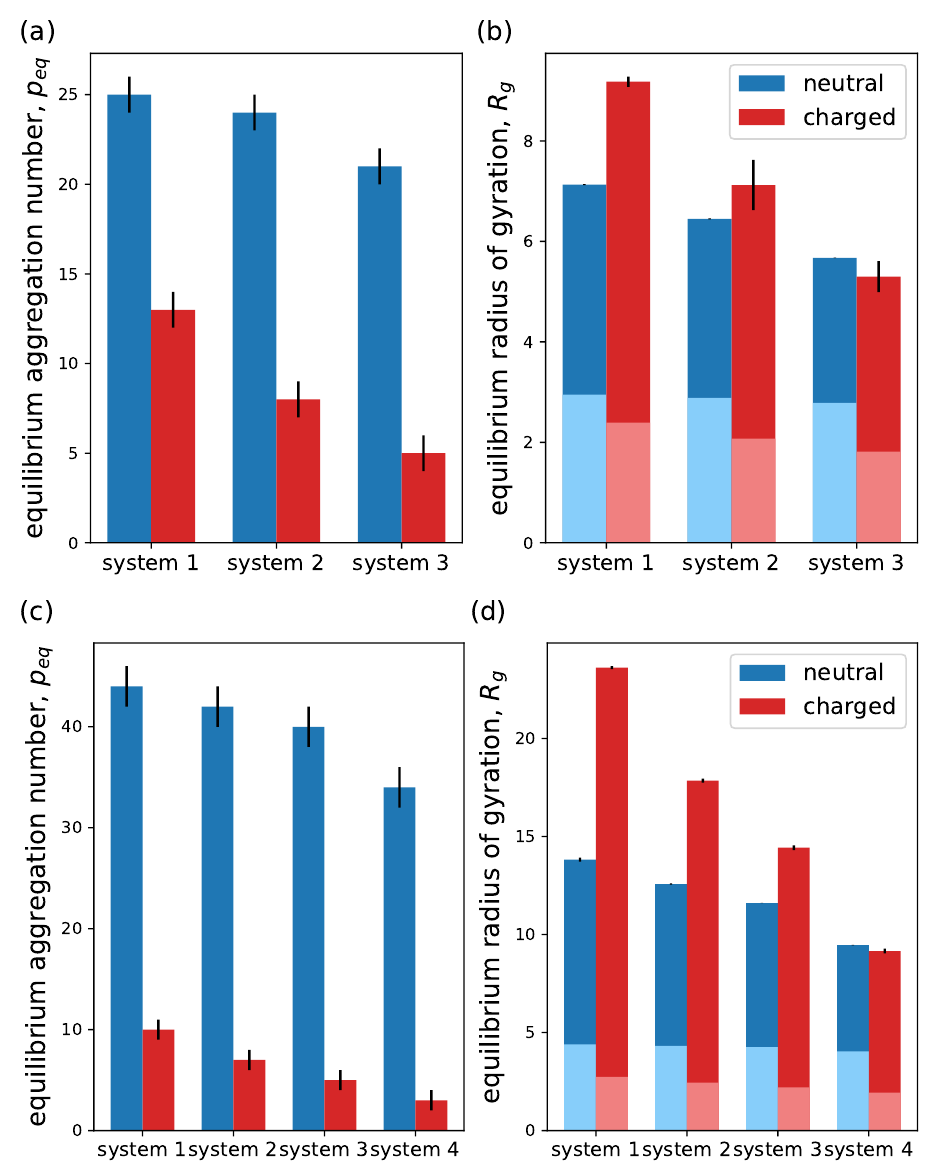
Figure 12. Equilibrium aggregation number and equilibrium radius of gyration for different block copolymers architectures. For insets ( a , b ), case 1 is plotted, with N A = 21 and N B = 10